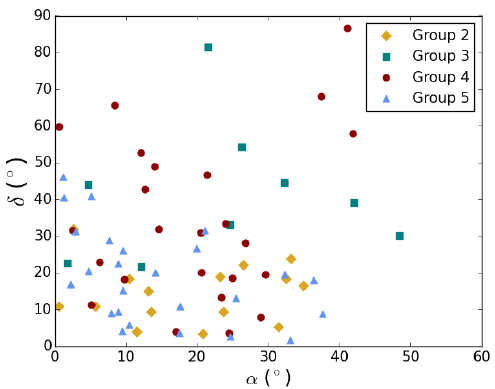
Figure 6. Distribution of the angle δ (between PMS normal and shock normal) versus the angle α (between shock angle and radial distance, absolute value). The different colours and symbols refer to the PMS groups: Near-Shock PMS (yellow diamonds), Mid-Sheath PMS (green squares), Near-LE PMS (red circles), Full-PMS sheath (blue triangles).